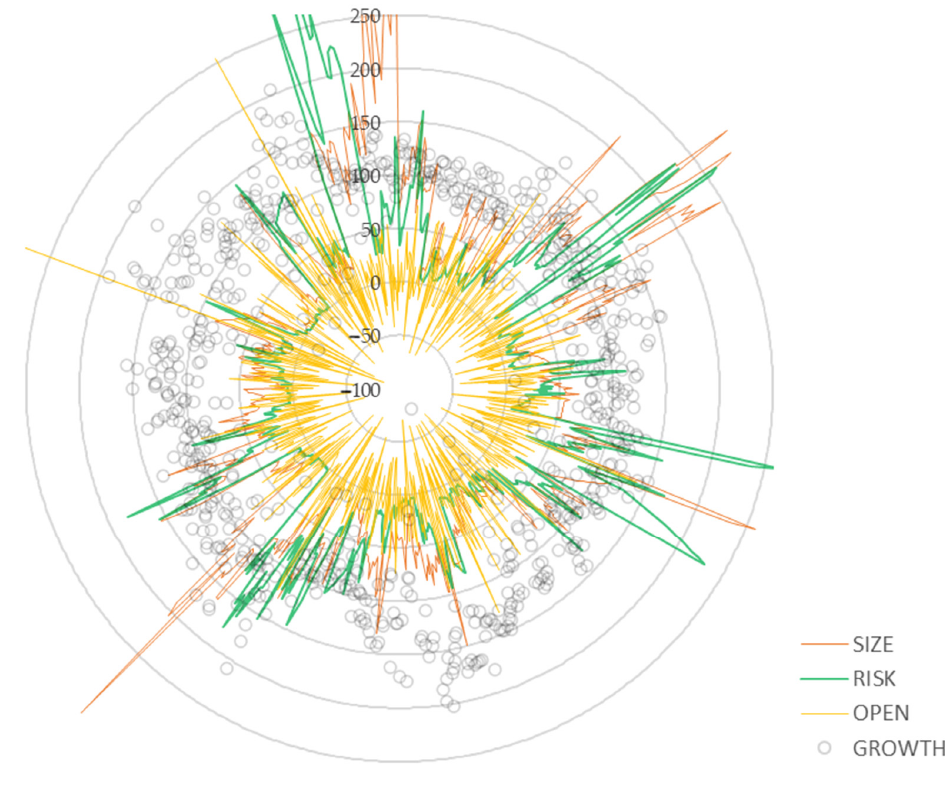
Figure 2. Size, risk diversification, openness of the stock market and economic growth. Table 2. Stationarity test, authors source.